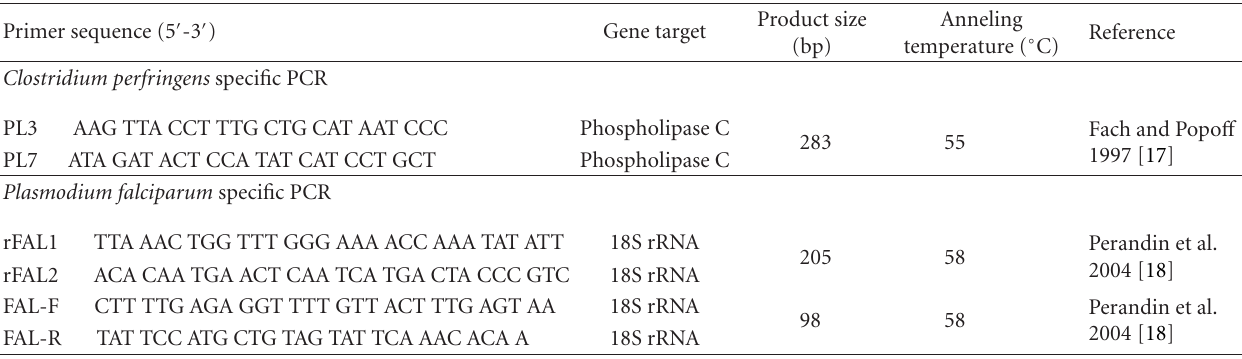
Table 1: Oligonucleotide primers used in the PCR assays. Primer sequence (5 (cid:2) -3 (cid:2)